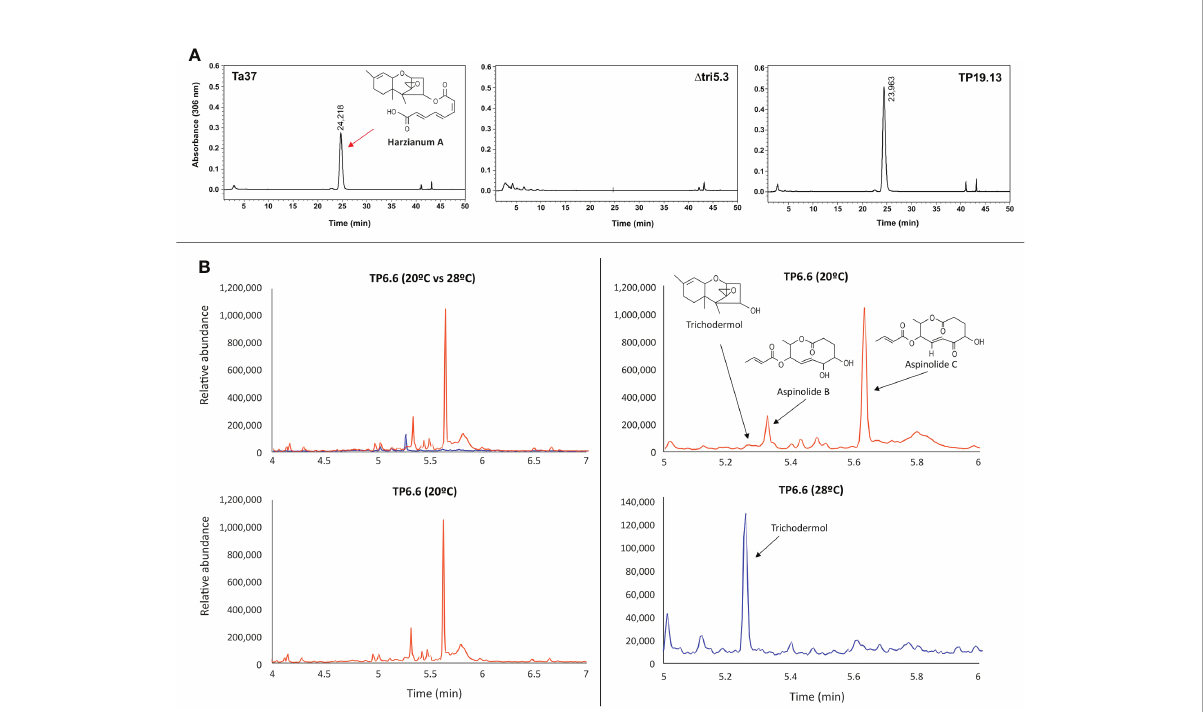
FIGURE 3 (A) Chromatograms from HPLC-UV analysis for determination of harzianum A production by T. arundinaceum IBT 40837 (Ta37) (wild-type strain); D tri5.3, a trichothecene non-producing mutant; and TP19.13 one of the three Trichoderma sp. strains recovered in the present work and selected for further studies. Red arrow indicates the peak corresponding to HA. Ta37 and D tri5.3 strains have been included for comparative purposes. (B) Chromatograms from GC-MS analysis for production of trichothecene intermediates (trichodermol) and aspinolides A and B from 7 days old culture supernatants of TP6.6 strain. Chromatograms in blue correspond to metabolites detected in cultures incubated at 28°C, and those in orange correspond to those incubated at 20°C. Note that a different scale was used in the lower right